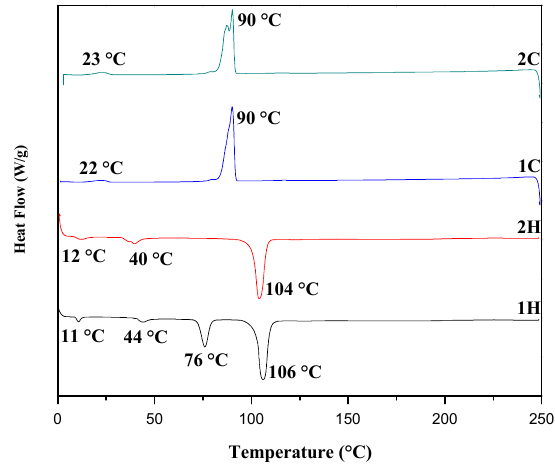
Figure 9. DSC thermograms of EV14 obtained at heating and cooling rates of 10 °C /min.